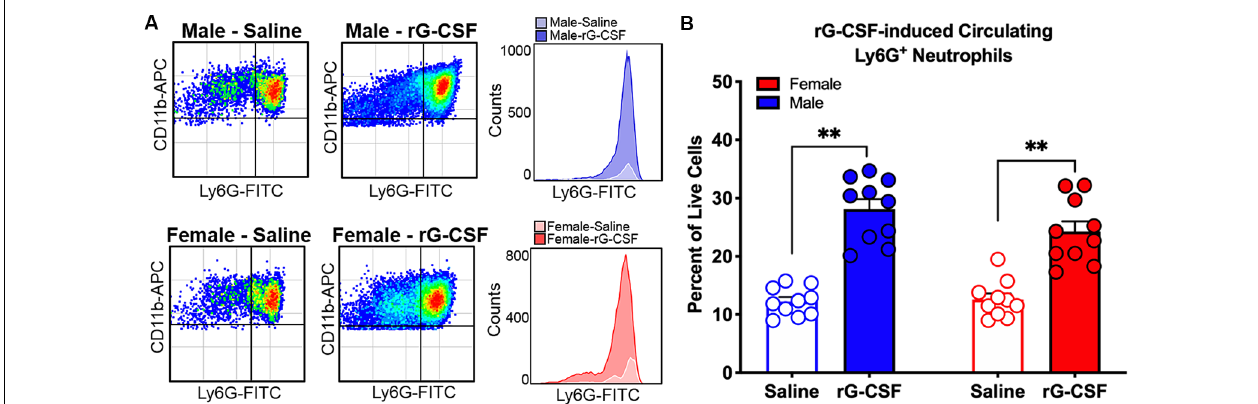
FIGURE 1 | Recombinant granulocyte colony stimulating factor (rG-CSF)-mediated mobilization of neutrophils was quantified using flow cytometry in adult C57Bl/6 mice. (A) Representative scatter plots showing CD11b + Ly6G + neutrophils in cardiac blood of a naïve male mouse (top) and a female mouse (bottom) 24 h after treatment with saline (left) or rG-CSF (right). Histograms demonstrate the increase in circulating neutrophil after rG-CSF treatment. (B) Average Ly6G + neutrophils quantification in cardiac blood from mice ( N = 10) 24 h following a single treatment of rG-CSF (5 µ g/mouse, i.p.) male (blue bars) and female (red bars) mice compared to saline treatment. Unpaired Student’s t -test, ∗∗ P < 0.01.